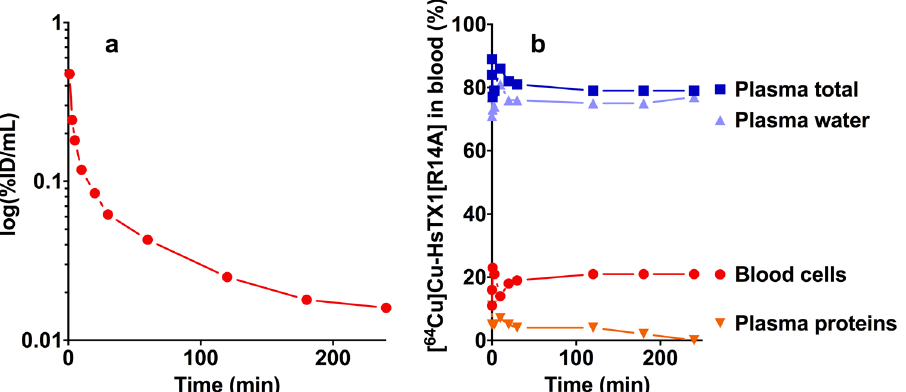
Figure 3. Distribution in the blood. ( a ) Representative time activity curve of the [ 64 Cu]Cu-NOTA- HsTX1[R14A] after single i.v. injection in the arterial blood with metabolite correction. ( b ) Distribution of the radiotracer in the blood compartments (blood cells, plasma, plasma water, plasma proteins) of a rat. The values are expressed as % of total blood